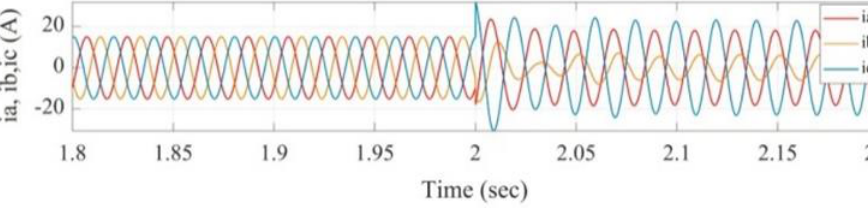
Figure 8. Current signals for 25% short circuit fault in phase c.